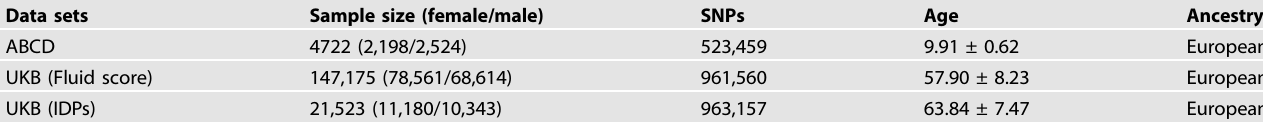
Table 2. Basic characteristics of individuals and SNPs for ABCD and UKB data sets. Data